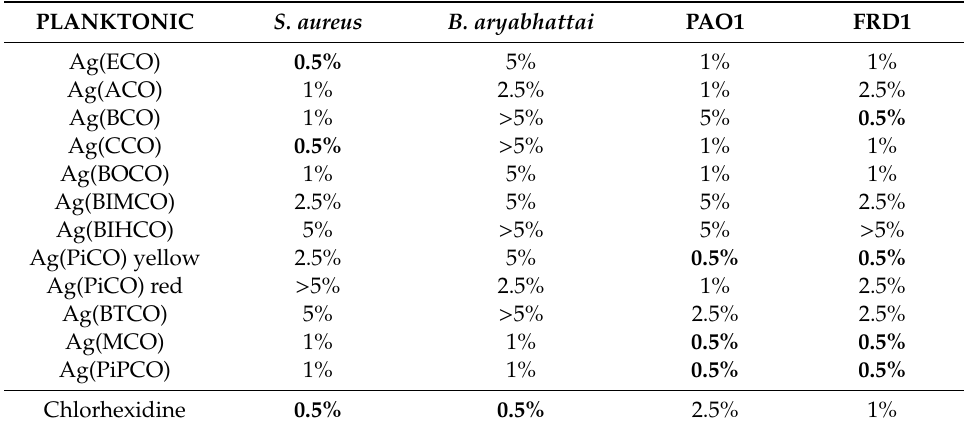
Table 3. The concentrations of the tested silver(I) cyanoximates embedded into polymeric composite that inhibited planktonic growth. The lowest inhibiting concentrations (0.5%) are shown in bold. Chlorhexidine was used as a reference